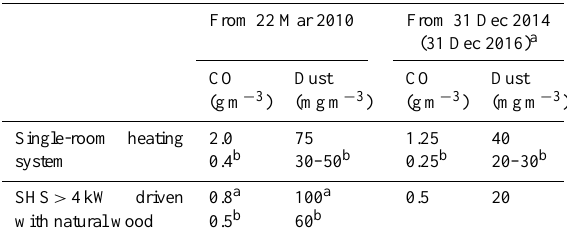
Table 1. Emission limits for small heating systems according to the 1st BImSchV (GFRG,